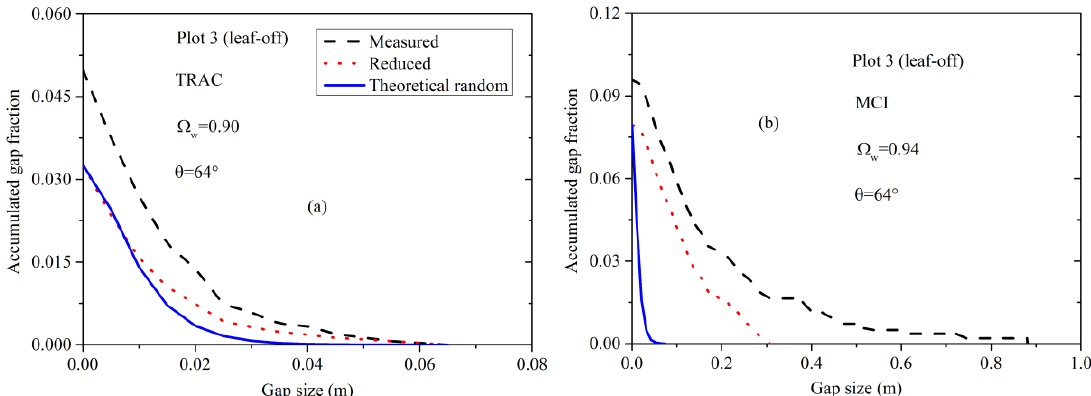
Figure 8. An example of the measured, reduced, and theoretical random accumulated gap size distributions obtained from TRAC and MCI in leaf-off plot 3 (a and b), respectively.